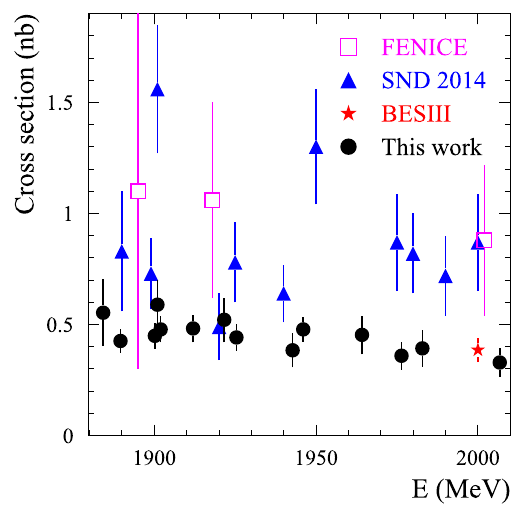
Fig. 14 The comparison of the e + e − → n ¯ n cross section measured in this work with the previous FENICE [1], SND [2], and BESIII [3] measurements. The combined statistical and systematic